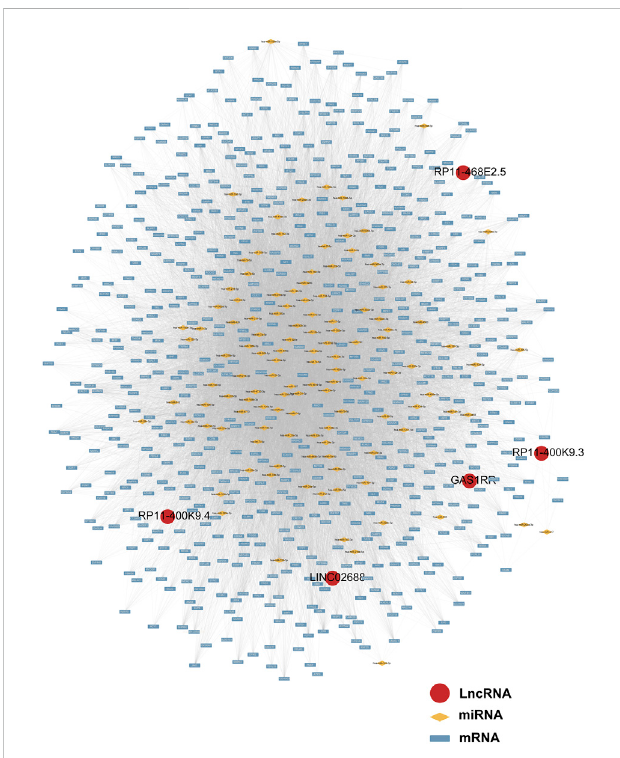
FIGURE 5 The ceRNA network of fi ve lncRNAs with potential miRNAs and